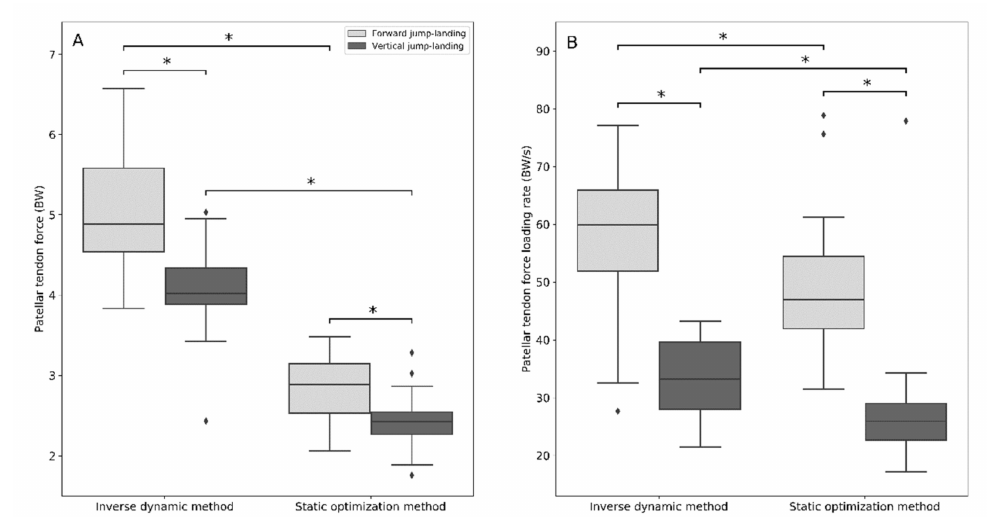
Figure 2. Patellar tendon force ( A ) and loading rate ( B ) of patellar tendon force experienced during vertical and forward jump-landing tasks estimated through inverse dynamic and static optimization methods. * Statistically significant difference ( p -value < 0.05). Diamond symbols represent